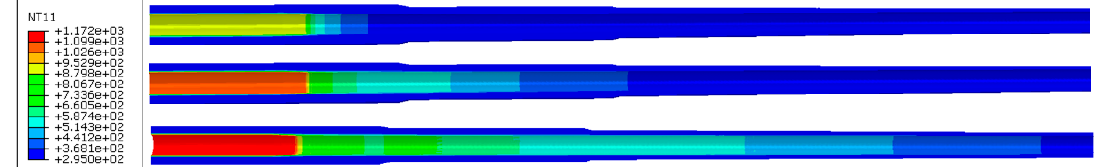
Figure 14. Temperature distribution of inner surface of the gun barrel at 10.5, 14.8 and 18.9 ms.